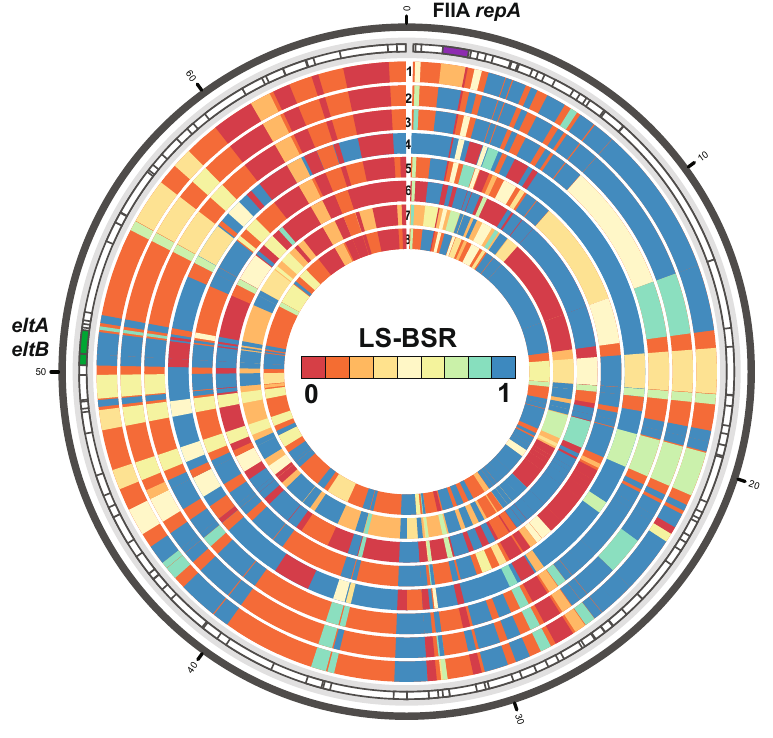
Figure 2. In silico detection of LT plasmid genes. The presence of protein-encoding genes with similarity to those of the previously sequenced LT-containing ETEC plasmid p666 from ETEC isolate H10407 28 , were identified in the EPEC/ETEC genomes using TBLASTN LS-BSR 17 . The outer track denotes the location of the protein-encoding genes of p666, while each of the inner tracks contains LS-BSR values indicating the presence (blue), divergence (yellow), or absence (red) of the genes in each of the genomes analyzed. The genomes analyzed are numbered as follows: 102651 (1), 102712 (2), 102771 (3), 402290 (4), E24377A (5), TW10509 (6), BCE019_MS13 (7), and B7A (8). The first four isolates are the EPEC/ETEC hybrid isolates and the other four isolates represent diverse ETEC